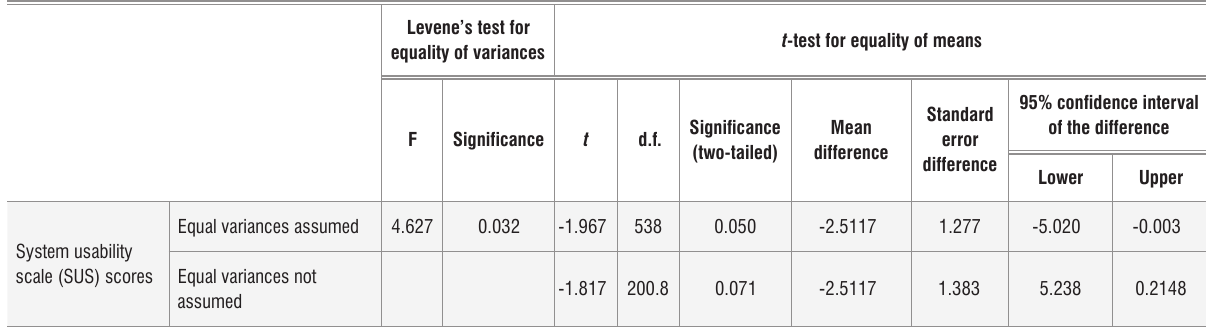
Levene’s test for equality of variances